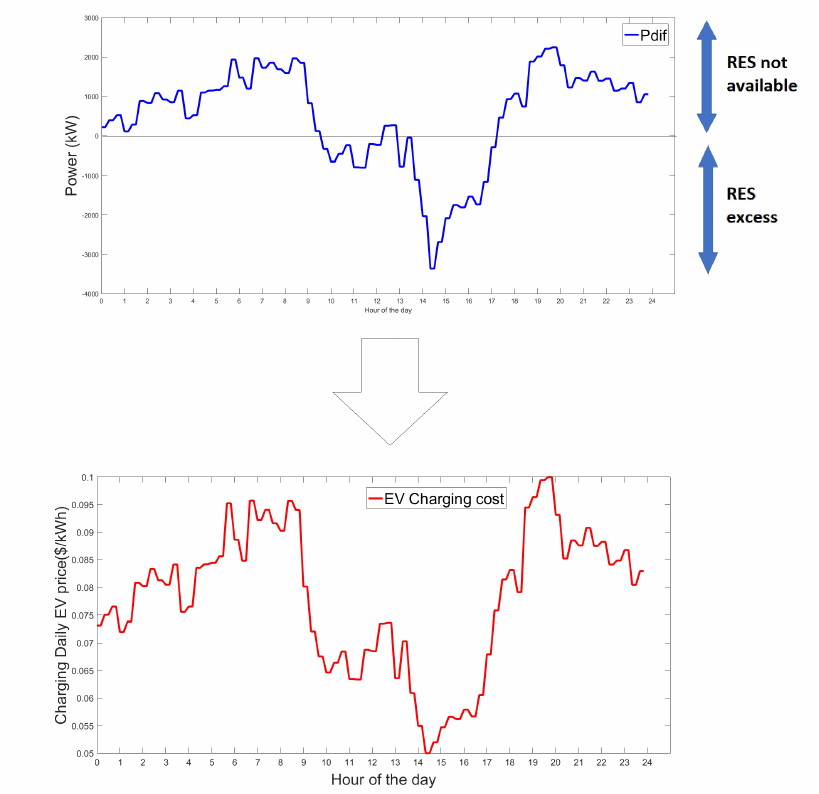
Figure 2. Residential load and RES power difference ( up ), and EV charging specific cost ( bottom )